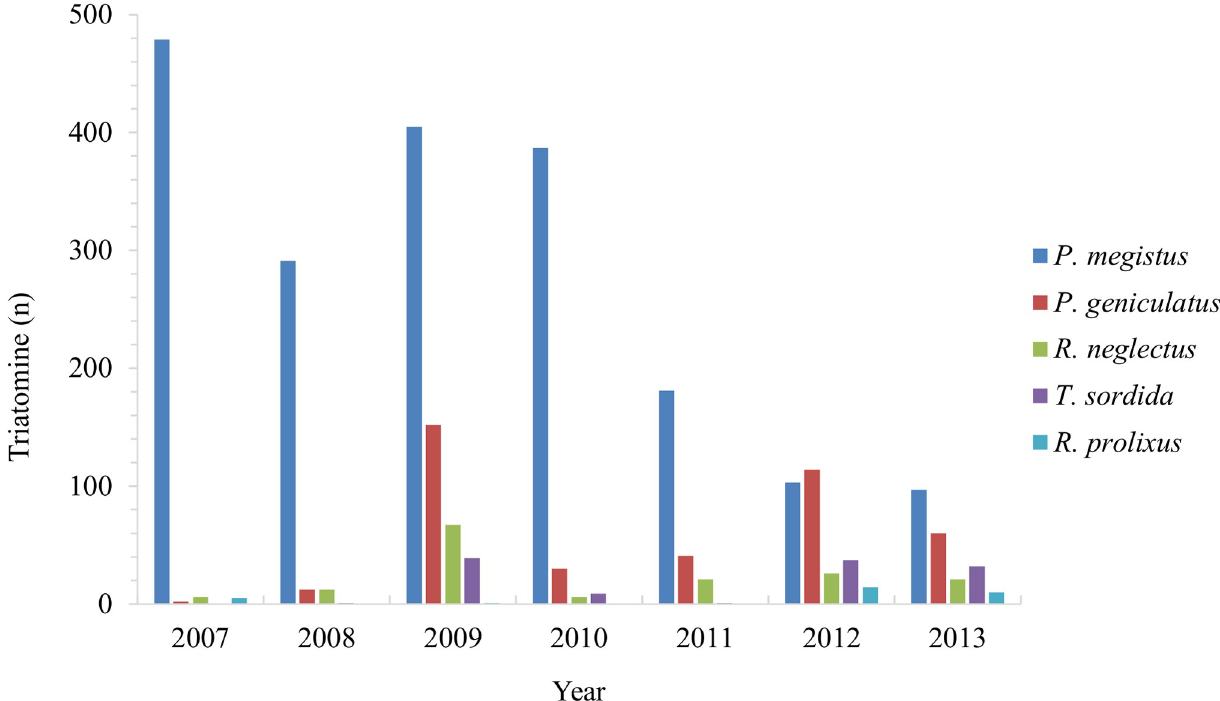
Fig 3. Number of triatomine specimens captured and their abundance during the study period in the State of Parana´, Southern Brazil.